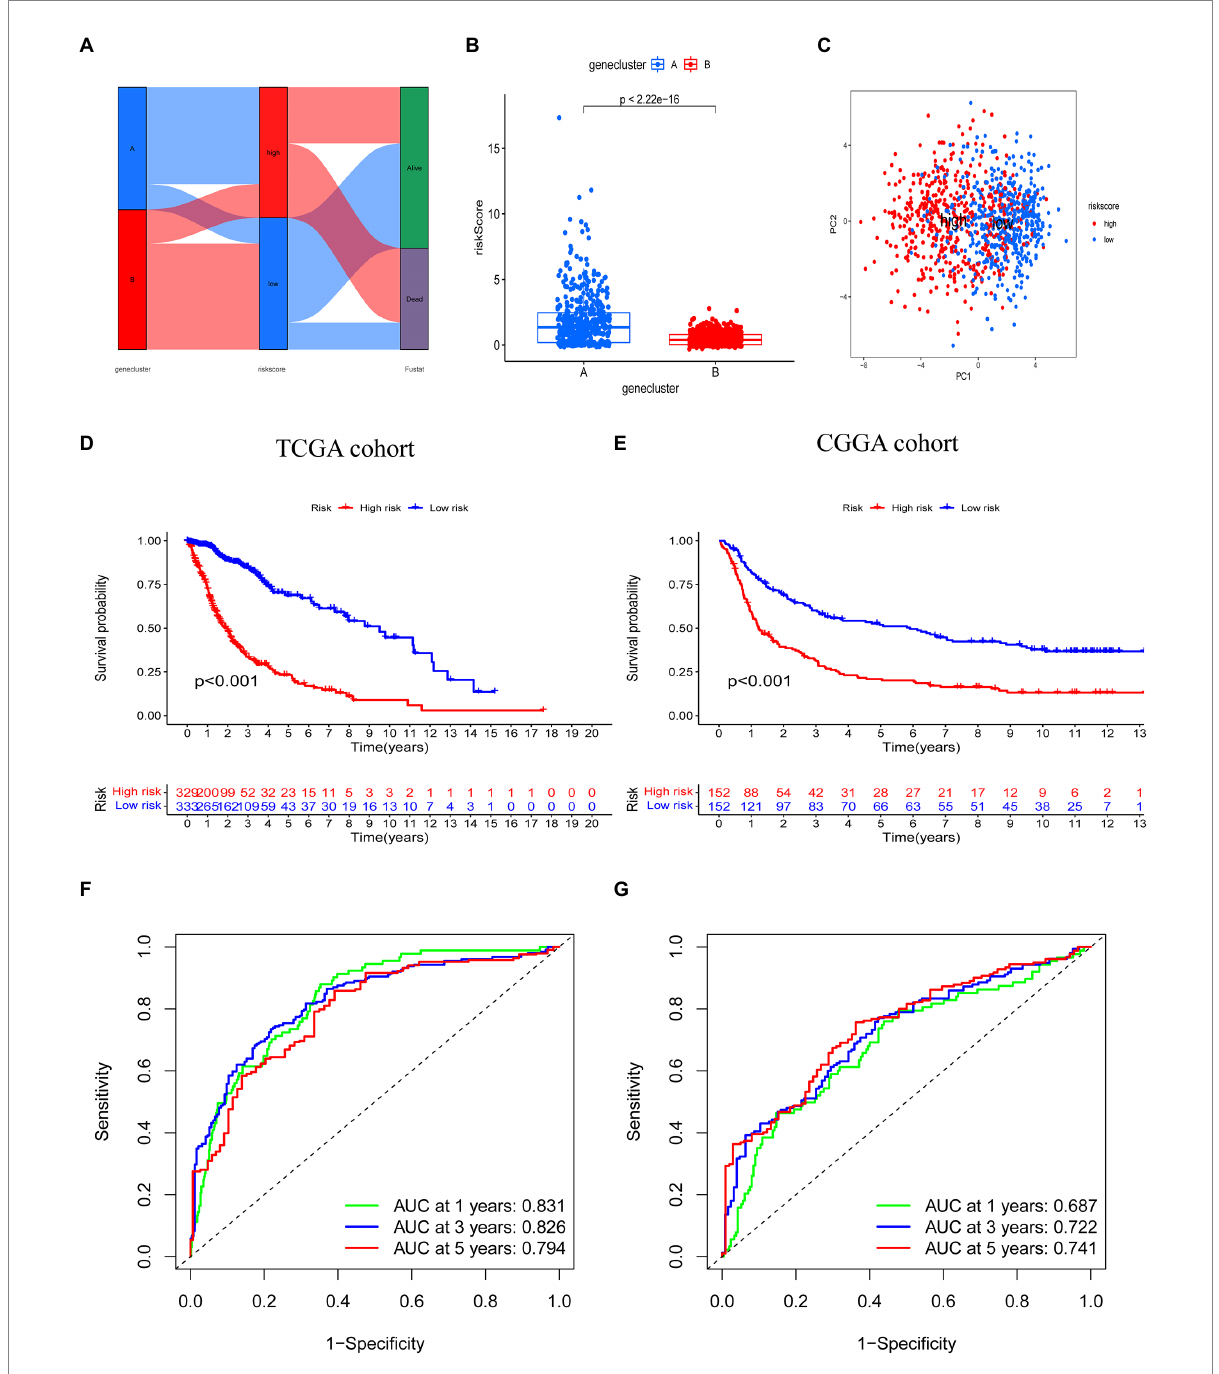
FIGURE 5 Prognostic value of the risk score model in glioma. (A) Alluvial diagram of subtype distributions in groups with different risk scores and survival outcomes. (B) Differences in risk score between genetic subtypes based on tryptophan metabolic gene expression. (C) Principal component analysis based on prognostic signature. High and low risk individuals are represented by red and blue dots, respectively. (D,E) Kaplan–Meier analysis of overall survival between the two groups in the TCGA and CGGA cohorts. (F,G) Receiver operating characteristic curves to predict the sensitivity and specificity of 1, 3, and 5-year survival according to risk score in TCGA and CGGA